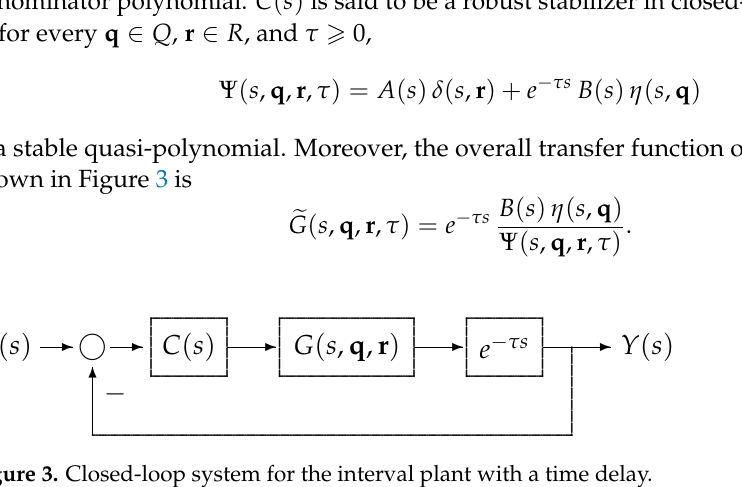
Figure 3. Closed-loop system for the interval plant with time-delay.